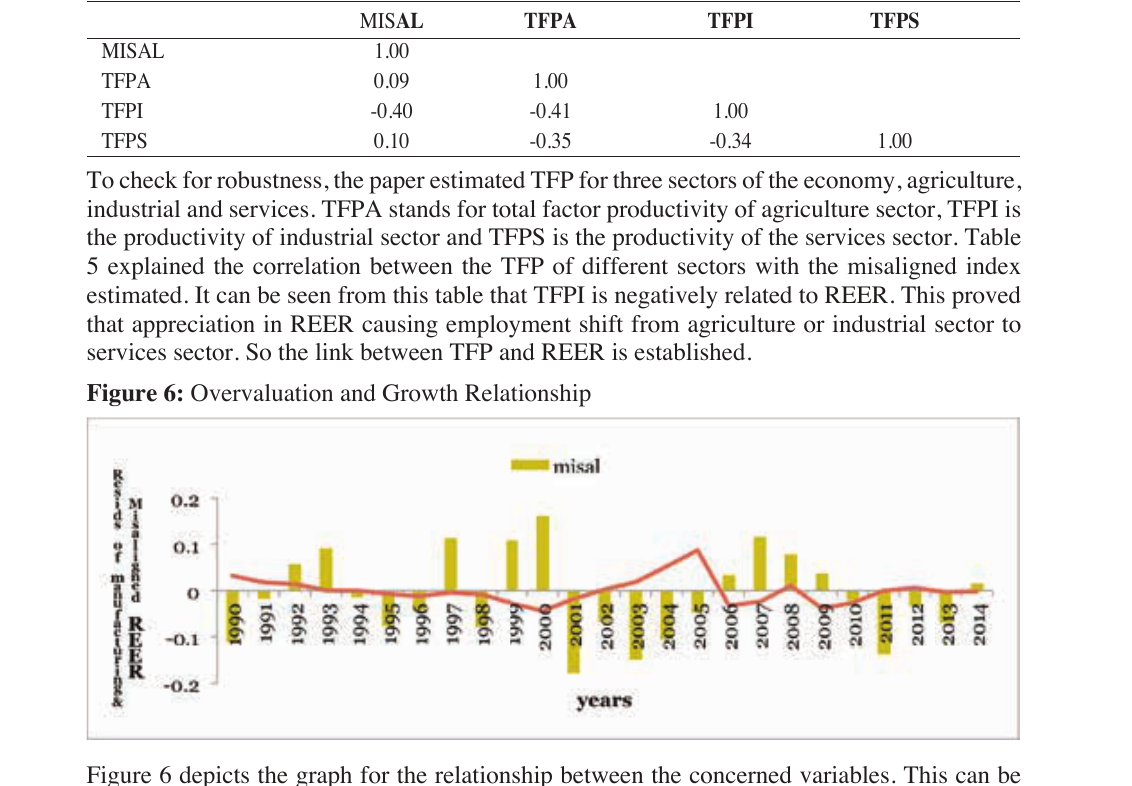
Table 5 : Correlation between REER and Economic Growth Proxy